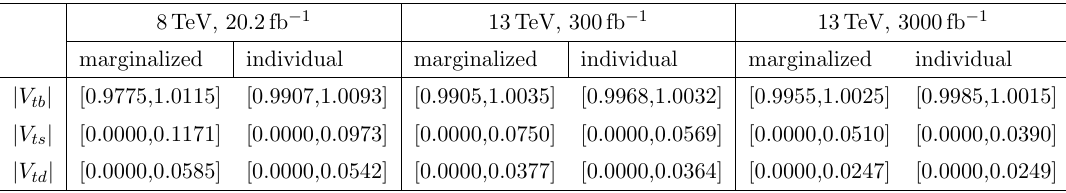
Table 4 . Expected 68% con(cid:12)dence interval for individual and marginalized (cid:12)ts of the j V td j , j V ts j and j V tb j CKM elements from the di(cid:11)erential cross section measurements of the single top production at 8 TeV LHC with 20.2 fb (cid:0) 1 and 13 TeV LHC with 300 fb (cid:0) 1 and 3000 fb (cid:0) 1 of recorded